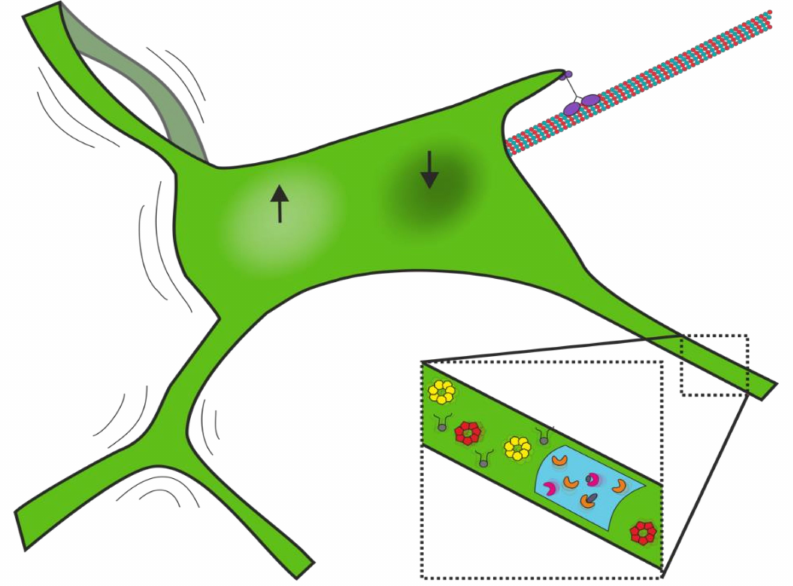
Figure 3. Schematic depicting the dynamics of the ER network. Fluctuations of the tubules, junctions, and sheets of the ER are shown with black lines and arrows. Tubules, junctions, and sheet edges oscillate laterally (within the plane of the page) and vertically (perpendicularly to the plane of the page). Vertical sheet fluctuations, as shown by the black arrows, are also thought to occur. The transmembrane and lumenal proteins also move, as shown in the inset. Motor proteins bind to the ER and move along microtubules to draw out new tubules from the existing network (see top